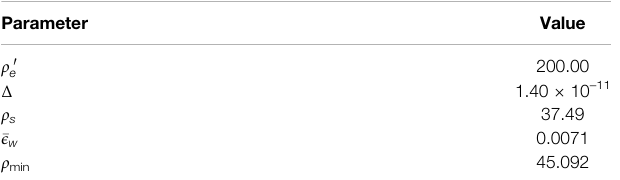
TABLE 6 | Equation 86 parameters from the second set of parameters for CSTR model in Table 5 .